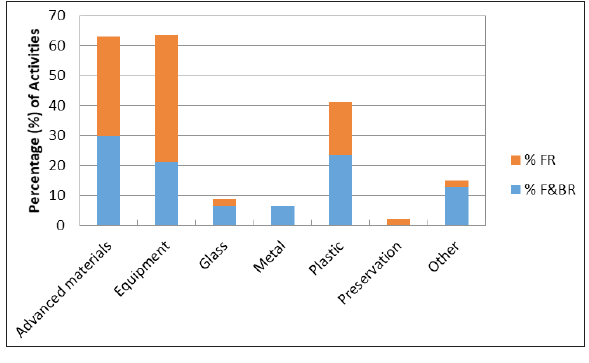
Figure 7: Scientific and technological advances by packaging types from Food & Beverage Reporter (F&BR) and South African Food Review (FR) data.